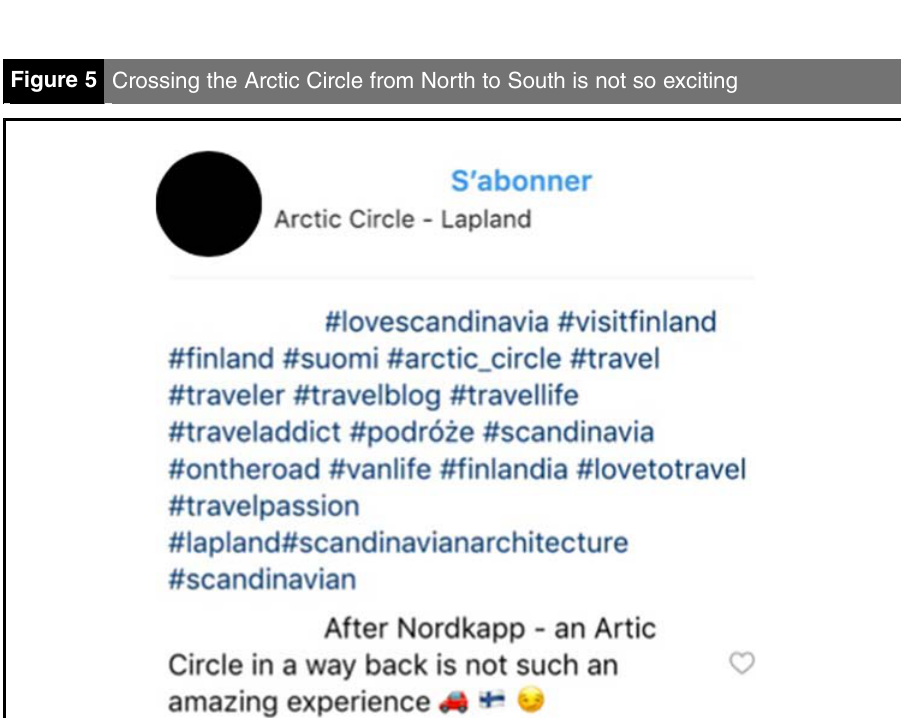
Figure 5 Crossing the Arctic Circle from North to South is not so exciting